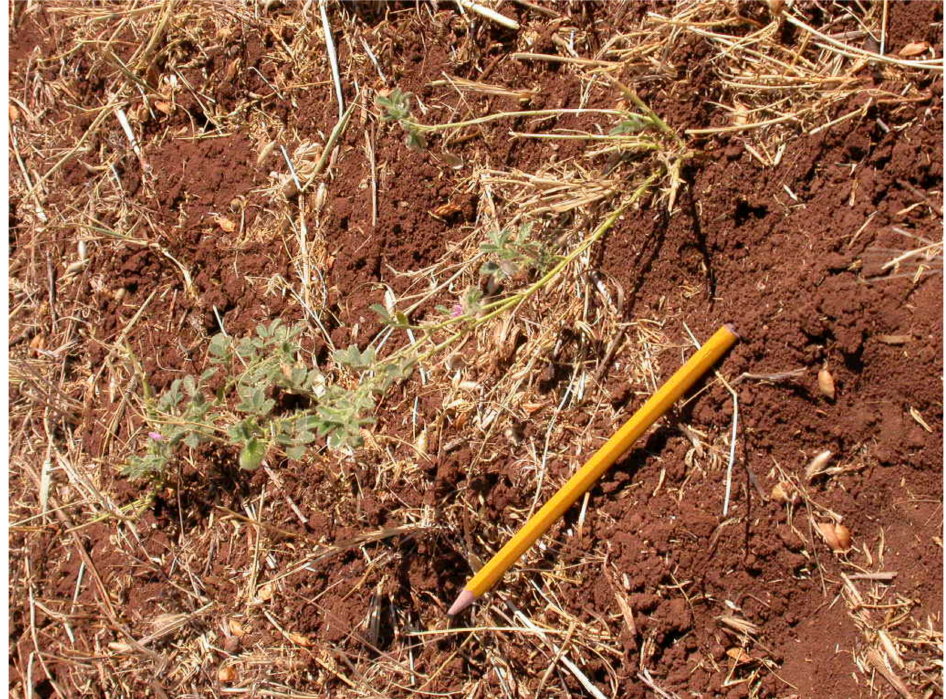
Figure 3. Wild C. bijugum after mowing and swathing in a lentil field between Hilvan and Siverek, southeast Turkey, June 2003. Note the leftovers from the lentil crop, surrounding plant parts including intact pods beside the pencil (photo by S.